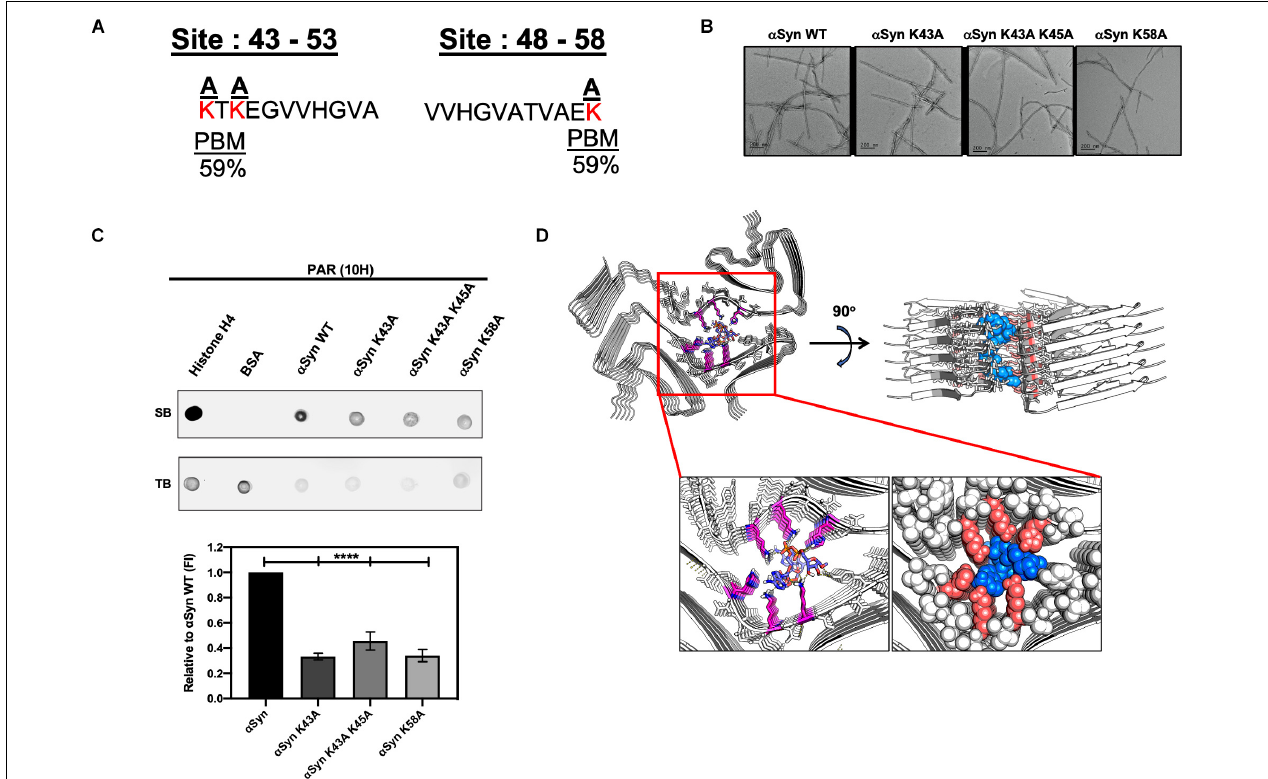
FIGURE 5 | Poly (ADP-ribose) interacts with α Syn via electrostatic forces in the N-terminal region of the protein. (A) Alignment of the full α Syn sequence with PBMs yielded a 59% PAR-binding probability at amino acid residues 43–54 and 48–58 on α Syn. Lysine amino acid residues (red) at the two sites were substituted to neutral alanine residues. (B) Three mutants of α Syn were generated with compromised PAR-binding sites. Two of the α Syn mutants had a point mutation at amino acid residues K43 and K58, respectively, while the third mutant had two point mutations at positions K43 and K45. All mutants were fully fibrillated within 72 h. Scale bar 200 nm. (C) PAR immunodot blot ( top panel ), whereby WT and mutant α Syn fibrils were spotted onto a membrane, along with, histone H4 (positive control), and BSA (negative control) and incubated with PAR polymer to assess PAR binding. Semi-quantitative analysis ( bottom panel ) of WT and mutant α Syn fibril signal intensity normalized to WT α Syn signal. One-way ANOVA ( n = 3). **** P < 0.0001. (D) Cryo-EM structure of MSA Type I α Syn fibril interacting with the PAR-dimer complex with a low free binding energy of –15.6